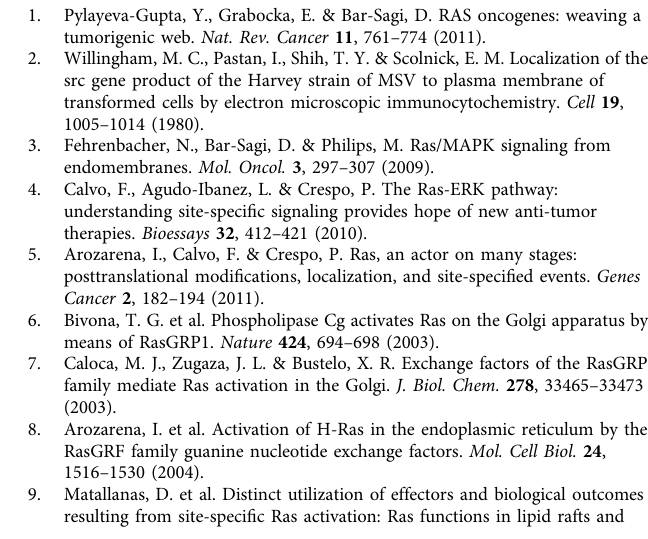
Supplementary Table 2. The nucleotide sequence is available from GeneBank: MG189366. Genome editing . Capped nls-zCas9-nls mRNA was synthesized using a mMES- SAGE mMACHINE SP6 kit (Life Technologies) from a pCS2 construct